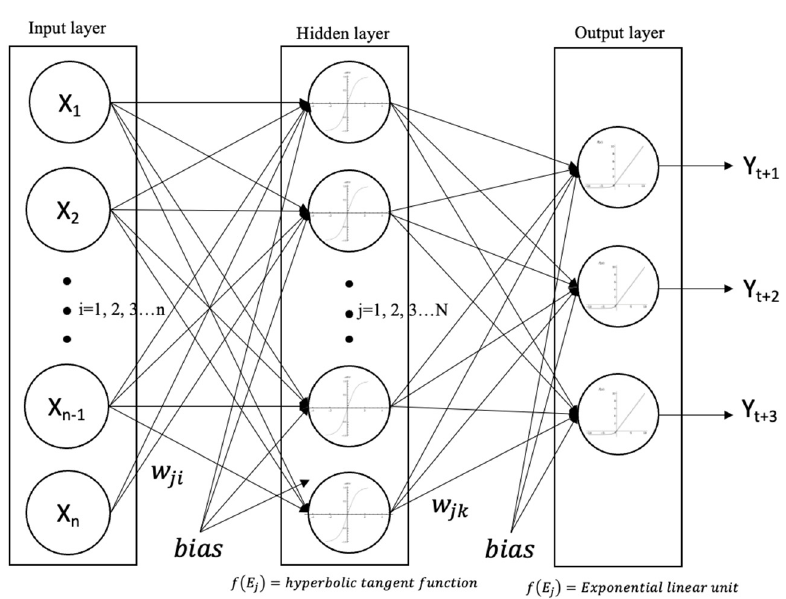
Figure 4. A three-layer ANN model and its data processing flowchart.